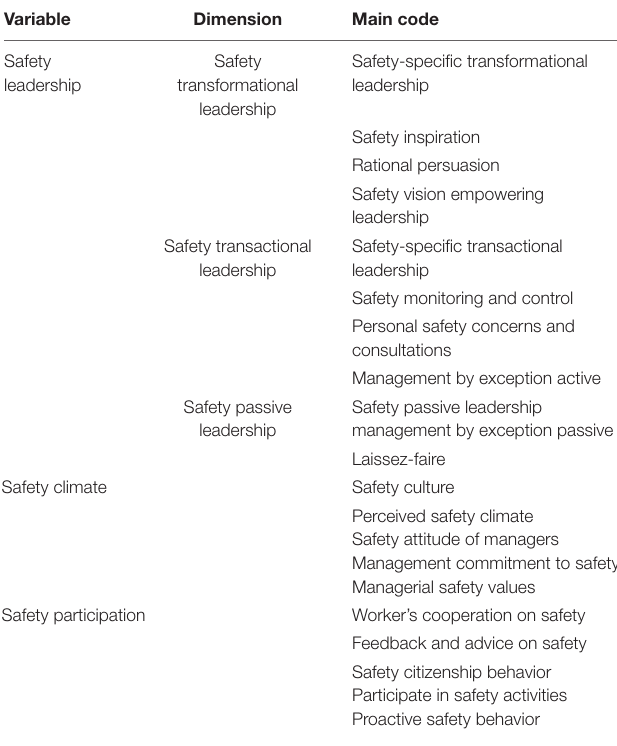
The final conceptual model is shown in Figure 1